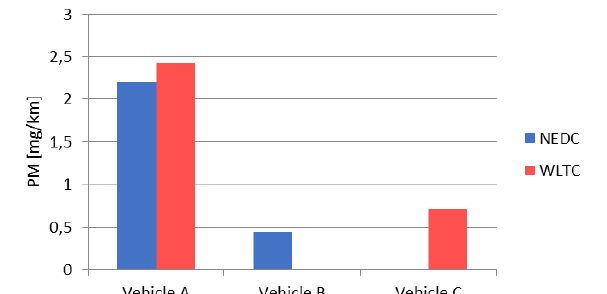
Fig. 17. Particle emissions in NEDC and WLTC